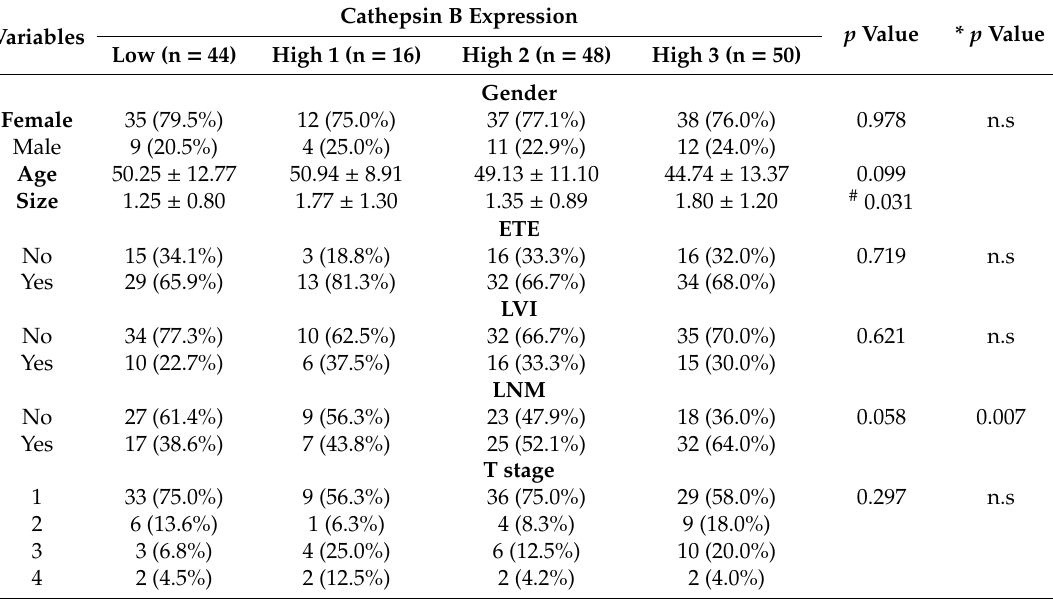
Figure 2. Higher expression of CTSB in PTC in clinical samples. ( A ) Expression of CTSB in normal (N) and tumor (T) samples from thyroid cancer patients. The band intensity of CTSB expression was measured with ImageJ and was normalized to GAPDH. The relative intensity of CTSB in normal tissue was set to 1. The band intensity of CTSB level in tumor tissue was calculated as fold-change compared to normal tissue. ( B ) Analysis of CTSB level between normal (N) and tumor (T) tissues in the patient samples of thyroid cancer. CTSB band intensity was normalized to GAPDH and was quantified using ImageJ. *** p < 0.001 ( C ) Analysis of CTSB expression in clinical samples with or without LNM. * p < 0.05 ( D ) Analysis of the relationship between occurrence (%) of LNM and CTSB expression levels. Table 1. Clinicopathologic features of thyroid cancer patients.